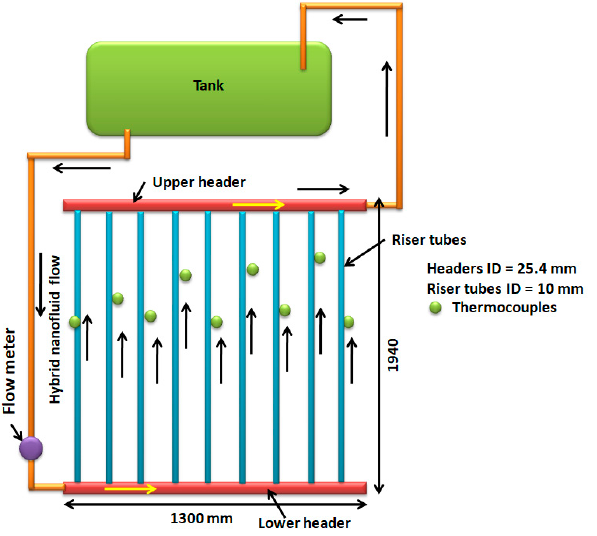
Figure 7. Schematic diagram of thermosyphon solar FPC.